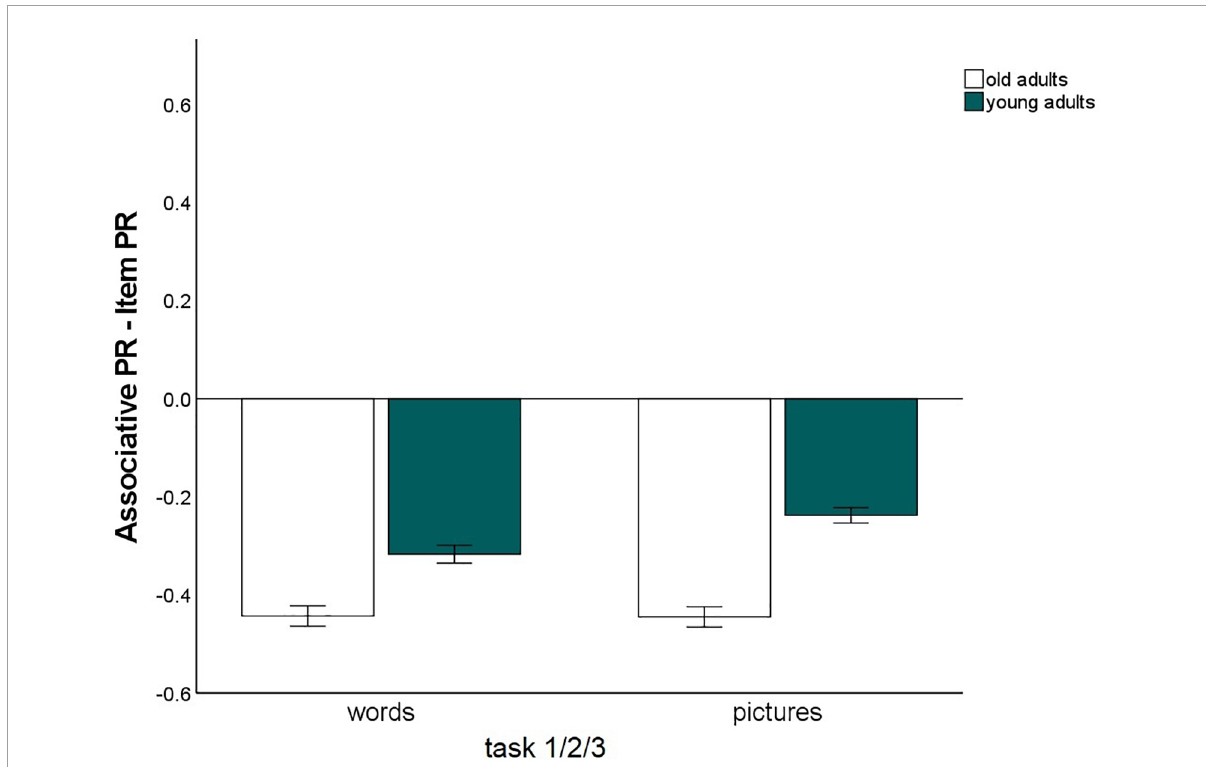
FIGURE3 Associative recognition PR, relative to item recognition PR, averaged over tasks 1, 2, and 3 (Difference between associative memory PR and item memory PR). Error bars represent the standard of the error mean.